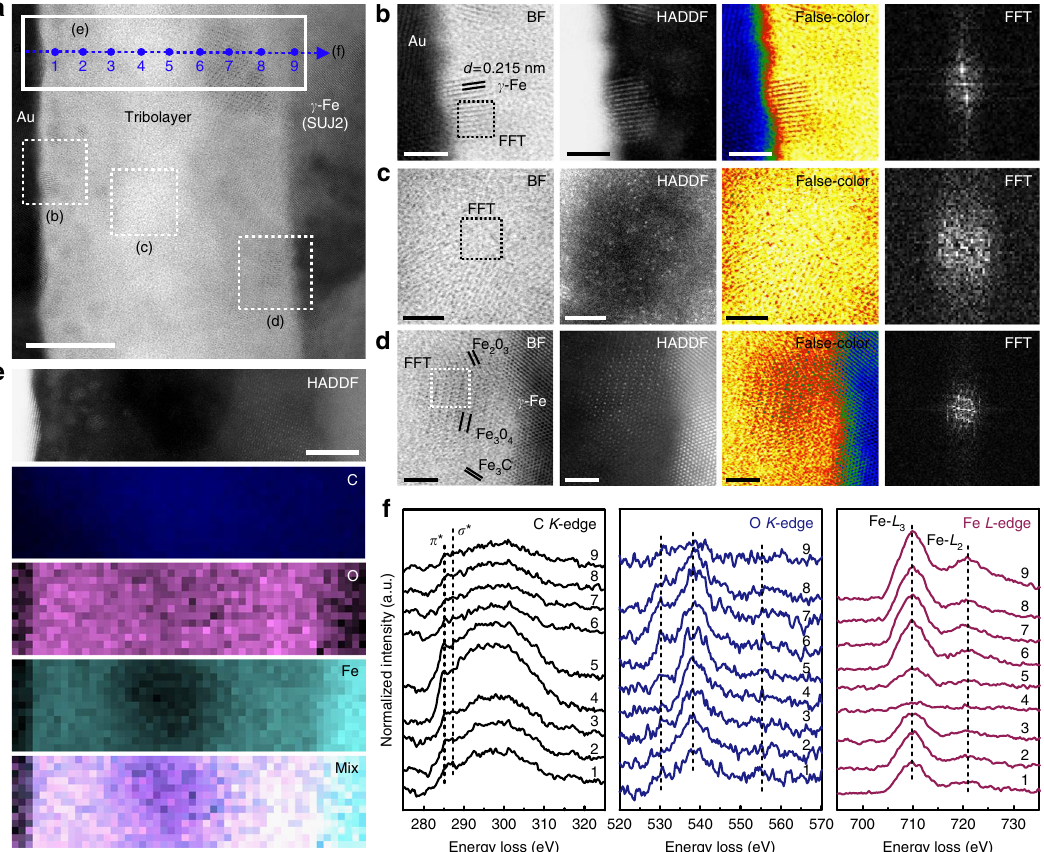
Fig. 3 Characterization of the contact area produced on bare SUJ2 steel ball surface. The corresponding superlubricity test paired with a-C:H (ACF-1) surface is shown in Supplementary Fig. 4. a BF-STEM image showing a carbonaceous tribolayer of ~ 27 nm thickness in situ generated on the steel ball surface. The tribolayer internally evolved into three individual sublayers (marked as b , c and d ): a Fe-nanoparticle-dispersed sublayer near the sliding interface, a C-rich low density sublayer in the middle and a C-Fe-O heterogeneously well-crystalized sublayer near the steel ball surface. Scale bar, 10 nm. b – d BF-, HAADF-, false-color displayed BF-STEM and local FFT images of the three sublayers as marked in a . Scale bars in b – d are all 2 nm. e HAADF- STEM image showing the EELS spectrum-image (SI) mapping area as marked in a . The corresponding EELS C-K, O- K , Fe- L elemental maps and their composite are presented. Scale bar, 5 nm. f Evolution of C-K , O- K and Fe- L EELS core-edge spectra recorded across the tribolayer as marked in